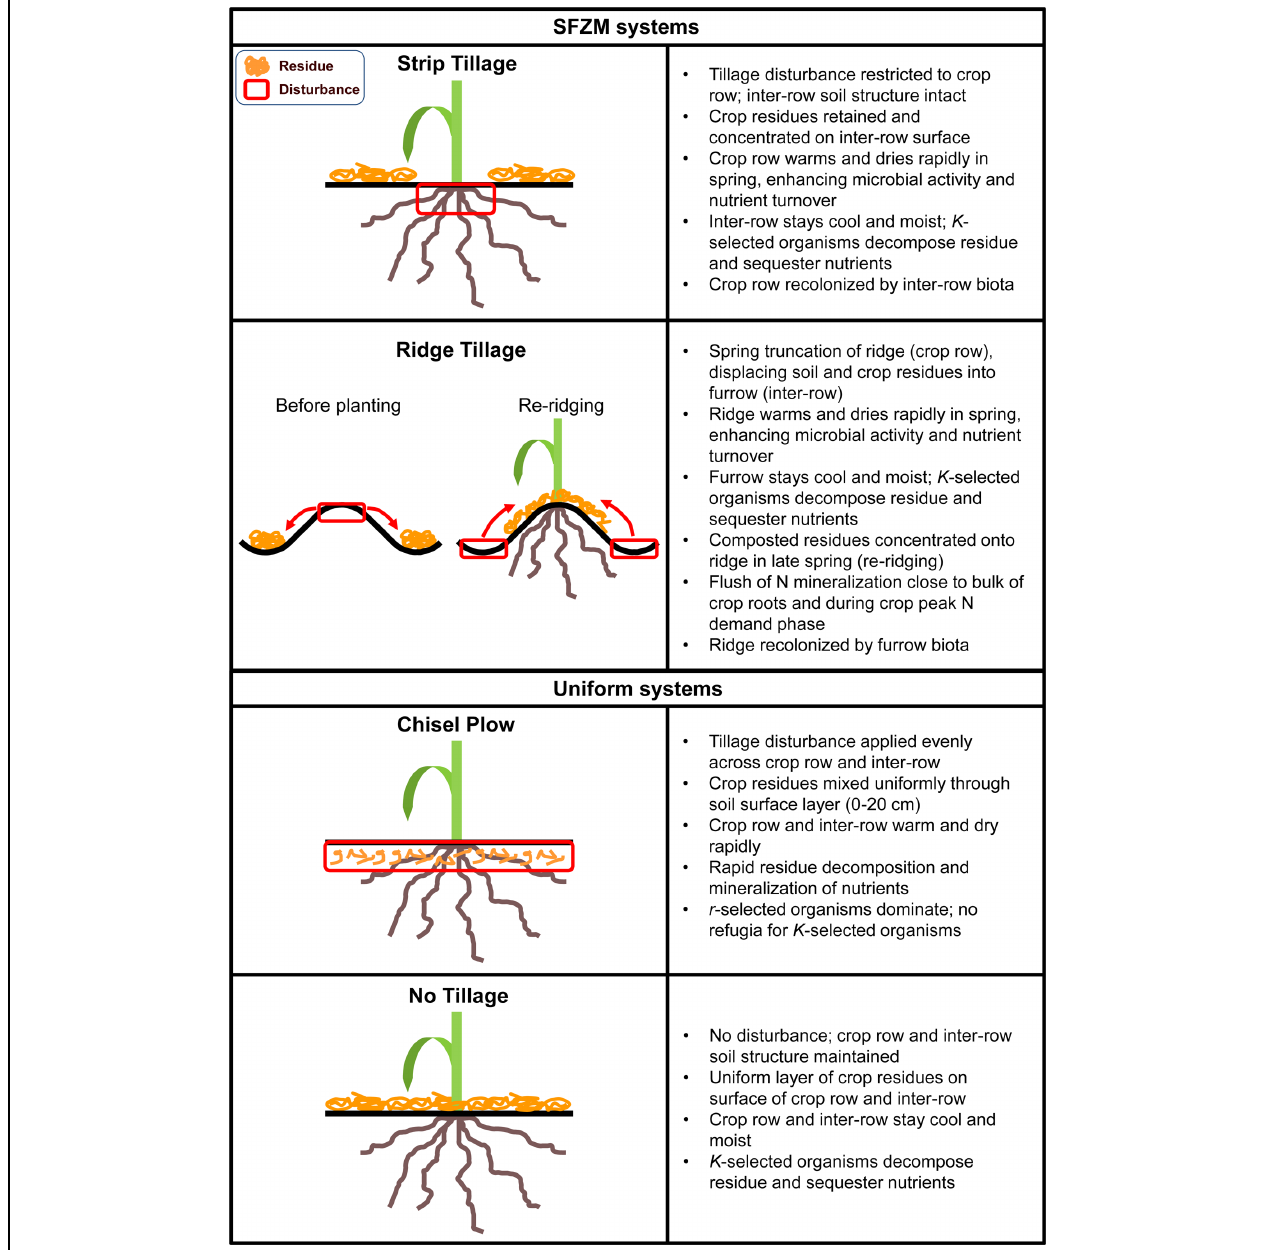
FIGURE 1 | Examples of typical soil functional zone management (SFZM) and uniform tillage